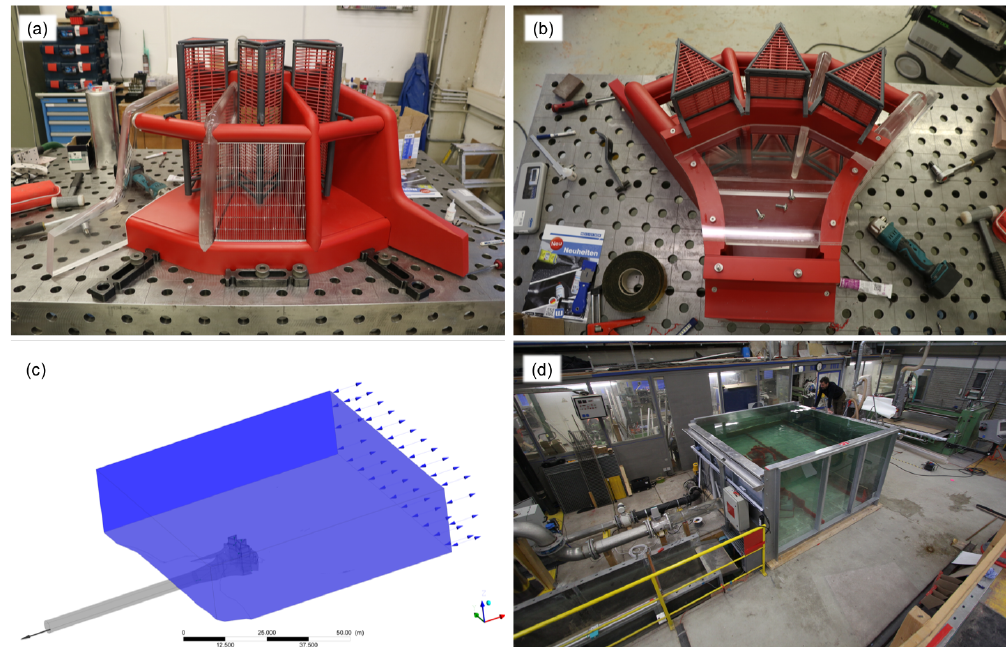
Figure 3. Triangular trash rack (option E 02) and intake structure on the modelling bench ( a , b ) and boundary conditions of the numerical model ( c ) compared to the filled scale model test ( d